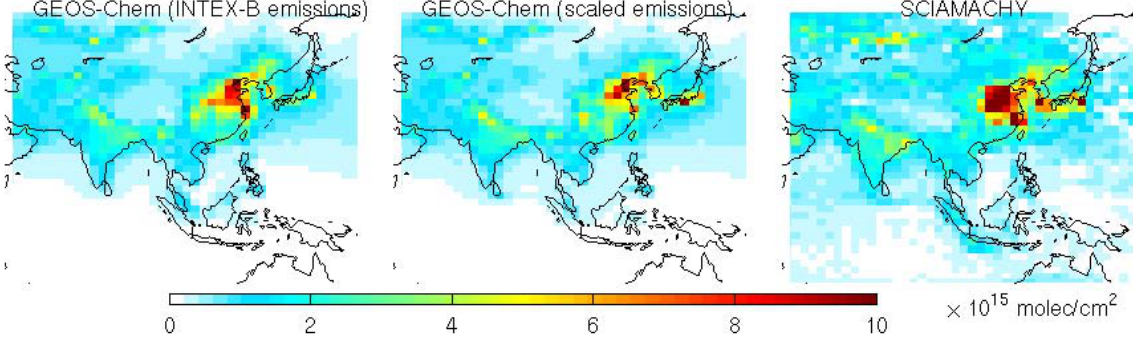
Fig. 4. Simulated and observed mean tropospheric NO 2 columns for April–May 2006. The left panel shows simulated columns from the baseline simulation, sampled at the satellite overpass times for SCIAMACHY. The central panel shows the same quantity for the GEOS- Chem simulation using the scaled emissions. The right panel shows NO 2 columns retrieved from the SCIAMACHY satellite